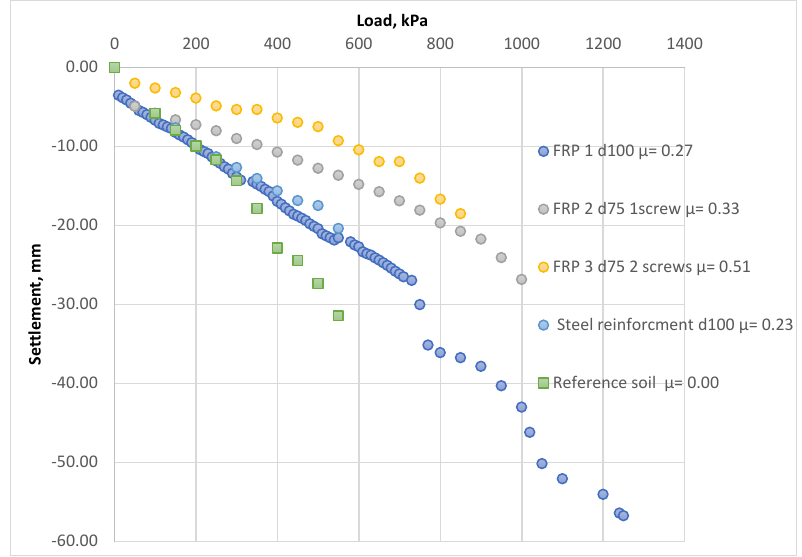
Figure 12. Results of the field tests.